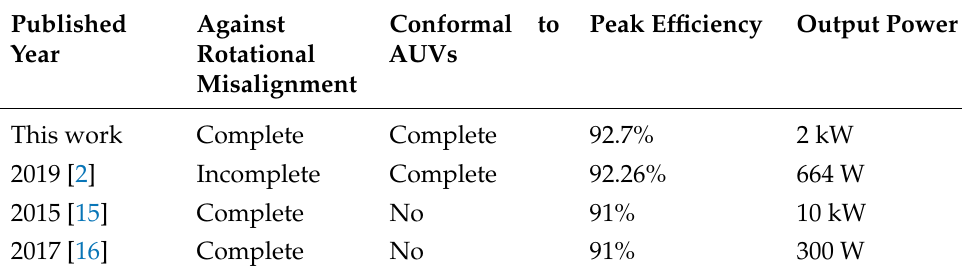
Figure 9. The variation curve of the output power with misalignments. ( a ) Rotational misalignment. ( b ) Radial eccentricity. ( c ) Axial eccentricity. Table 3. Performance of existing WPTs for